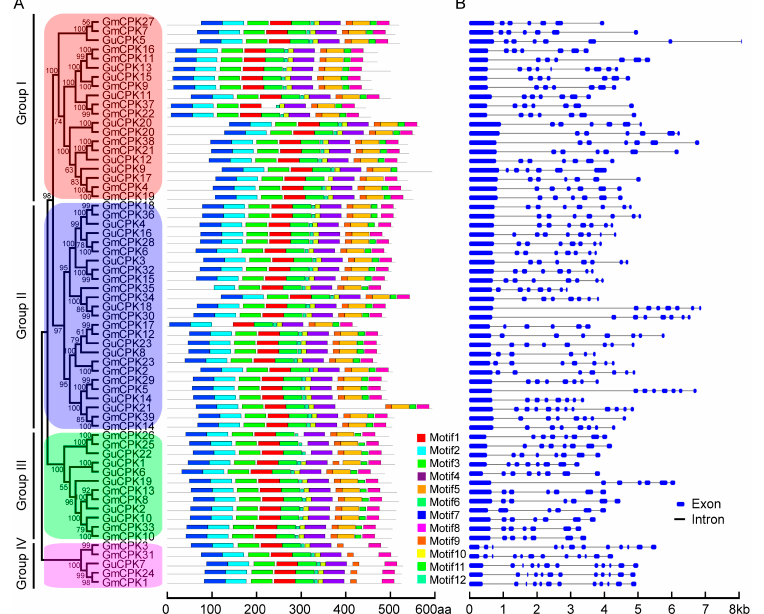
Figure 4. Motif distribution and exon/intron structure analyses of CPK family genes in G. uralensis and G. max . ( A ) Conserved motif analysis of CPK proteins. The GuCPK and GmCPK protein sequences were used to identify conserved motifs by the MEME program. ( B ) Exon/intron structure analysis of CPK genes. Blue boxes and black lines represent the exons and introns respectively, and the genomic length is indicated at the bottom.